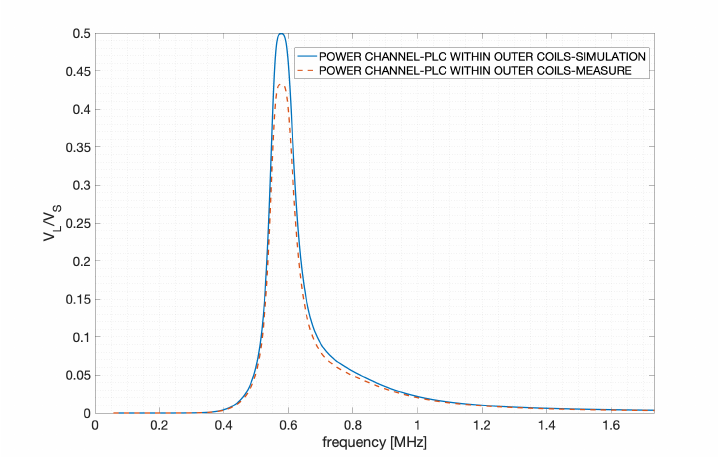
Figure 9. Transfer functions comparison between measurement and calculations for the power channel, case